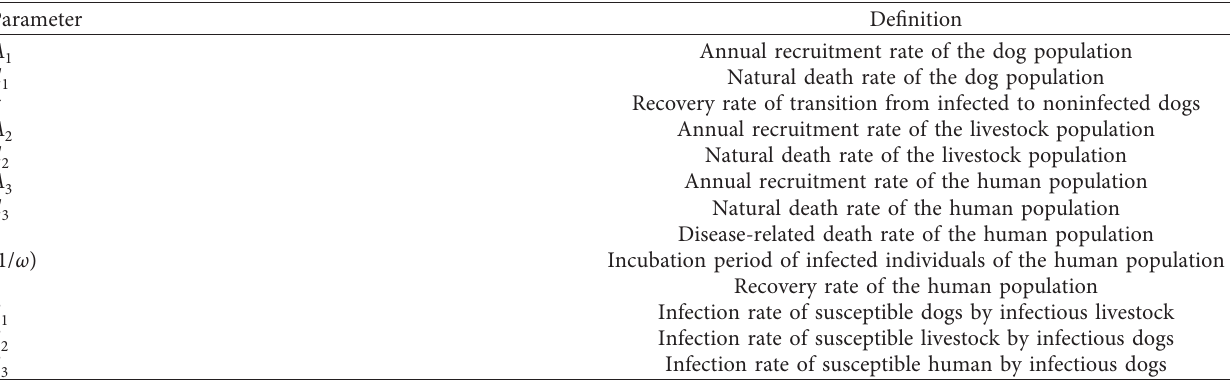
Table 2: Parameters in the model (adapted from